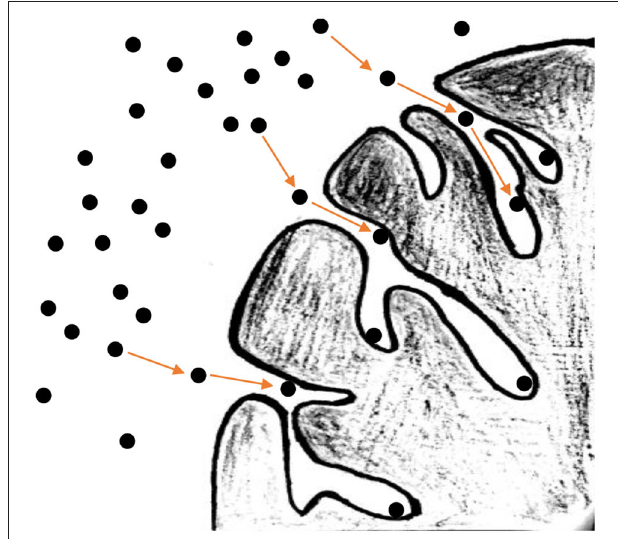
FIGURE 2 | Adsorption process